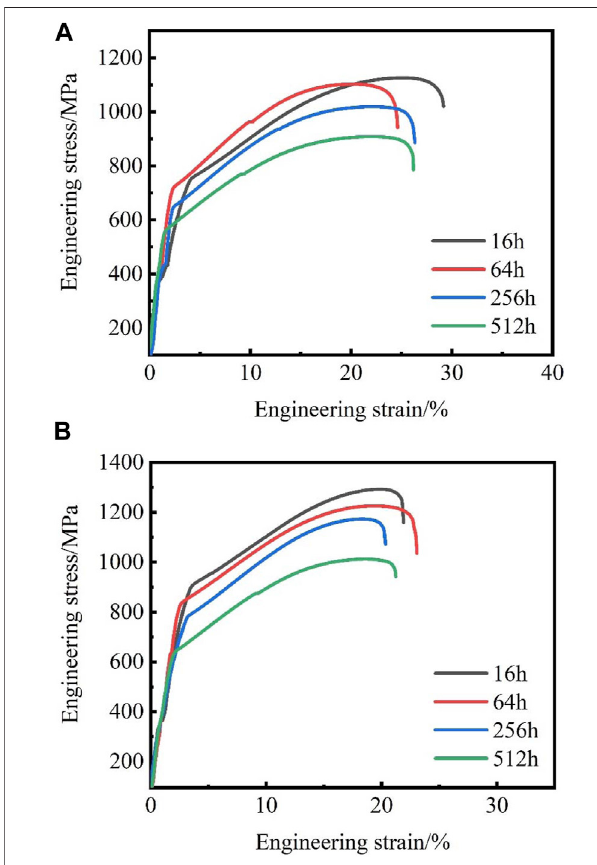
FIGURE 6 | Stress-strain curves of Co-based superalloys at room temperature: (A) 2Cr, (B) 2Mo.